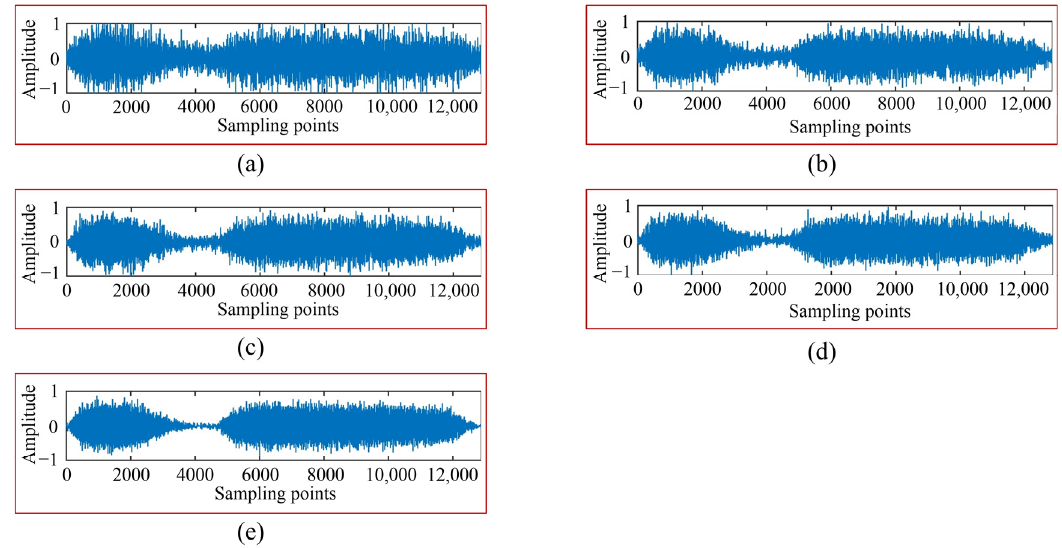
Figure 7. Five algorithms for denoising output waveform. (SNR in = 10 dB). ( a ) EMD denoised output signal; ( b ) CEEMDAN denoised output signal; ( c ) CEEMDAN-PSO denoised output signal; ( d ) CEEMDAN-FOA denoised output signal; ( e ) Improved CEEMDAN denoised output signal.